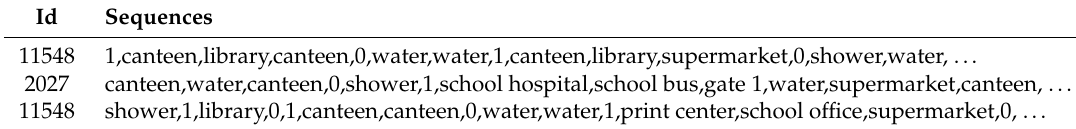
Table 8. The samples of students’ behavioral